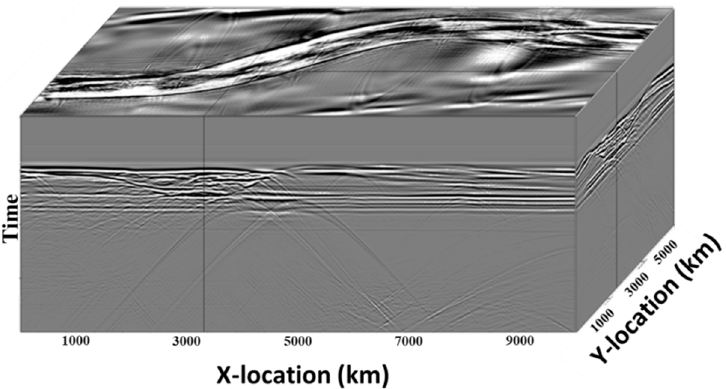
Figure 9. Zero-offset cube computed by the adaptive FD scheme for the model shown in Figure